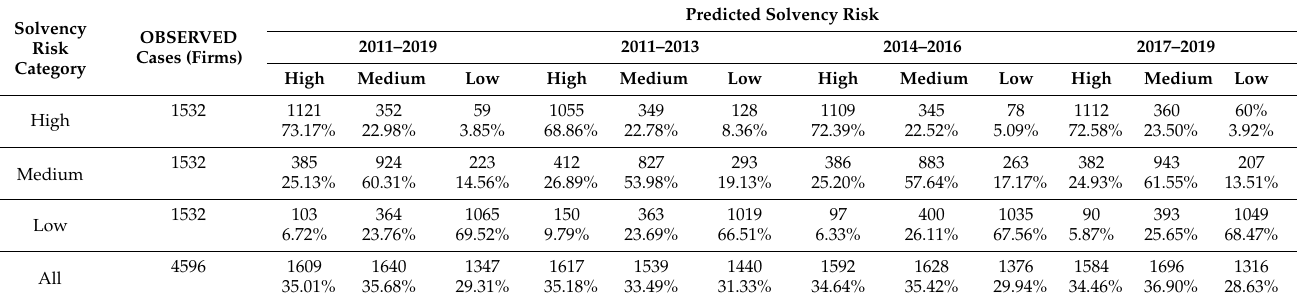
Table 7. Classification matrix, all periods and firms.